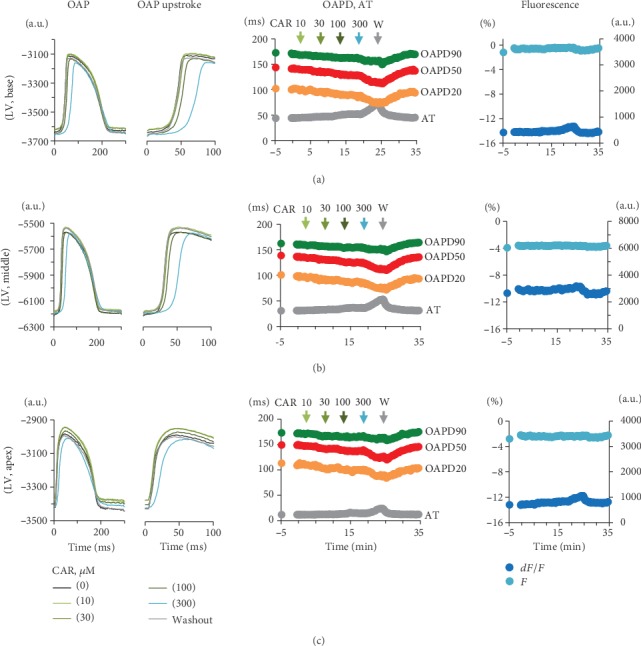
Effects of CAR on the OAPs of the Langendorff-perfused rabbit hearts. (a–c) Data obtained at the LV base, middle, and apex, respectively. Superimposition of OAPs and their upstrokes on an expanded time scale (left) of time-dependent changes in AT (grey) and the duration of OAPD20 (yellow), OAPD50 (red), and OAPD90 (green) (middle) of time-dependent changes of fluorescence in a.u. (F, light blue) and changes in the voltage-sensitive fraction of fluorescence in percent (dF/F, blue) versus time (right). The arrows above the graphs of OAPDs and AT (middle) indicate start of perfusion with corresponding concentration of CAR.